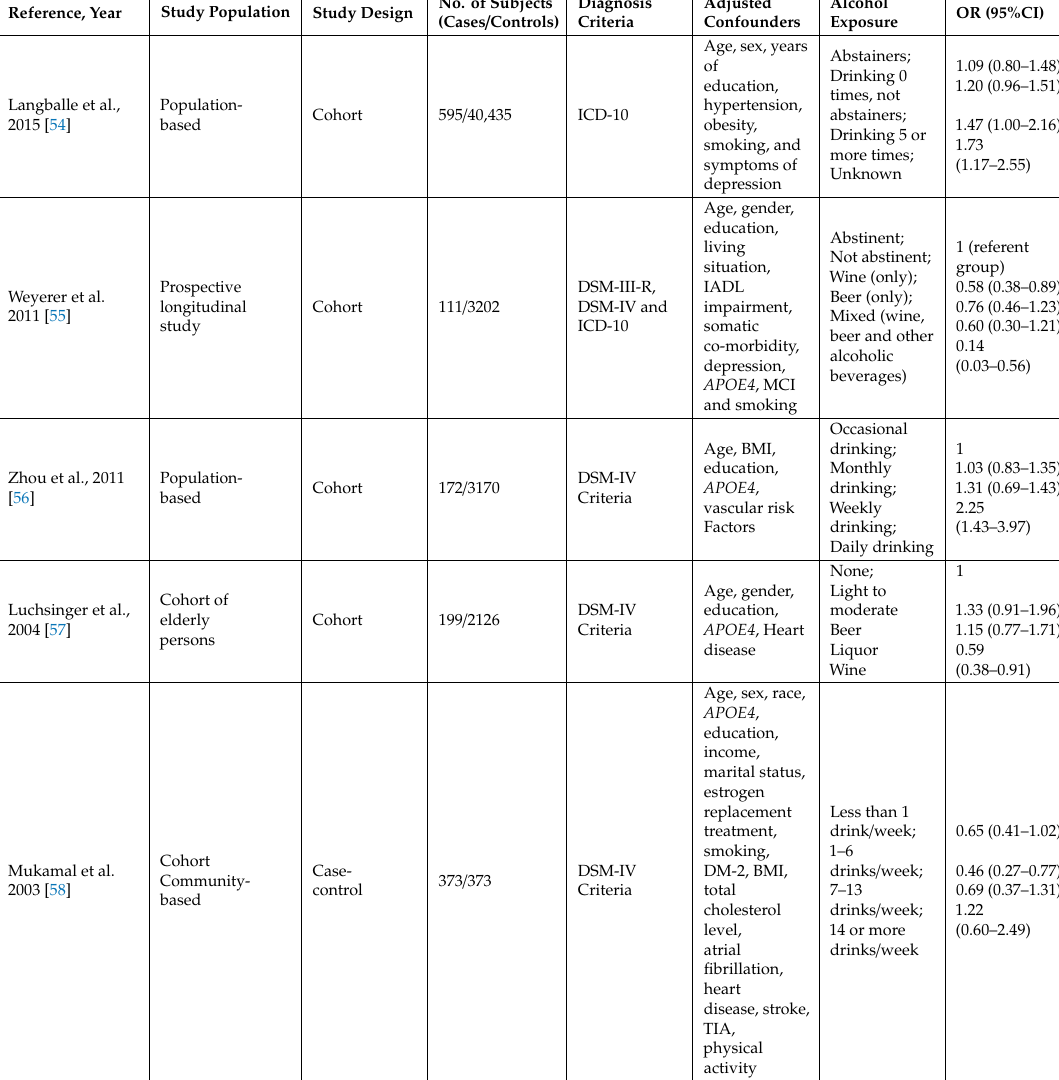
Table 2. Evidence-based reviews on the relationship between alcohol intake and